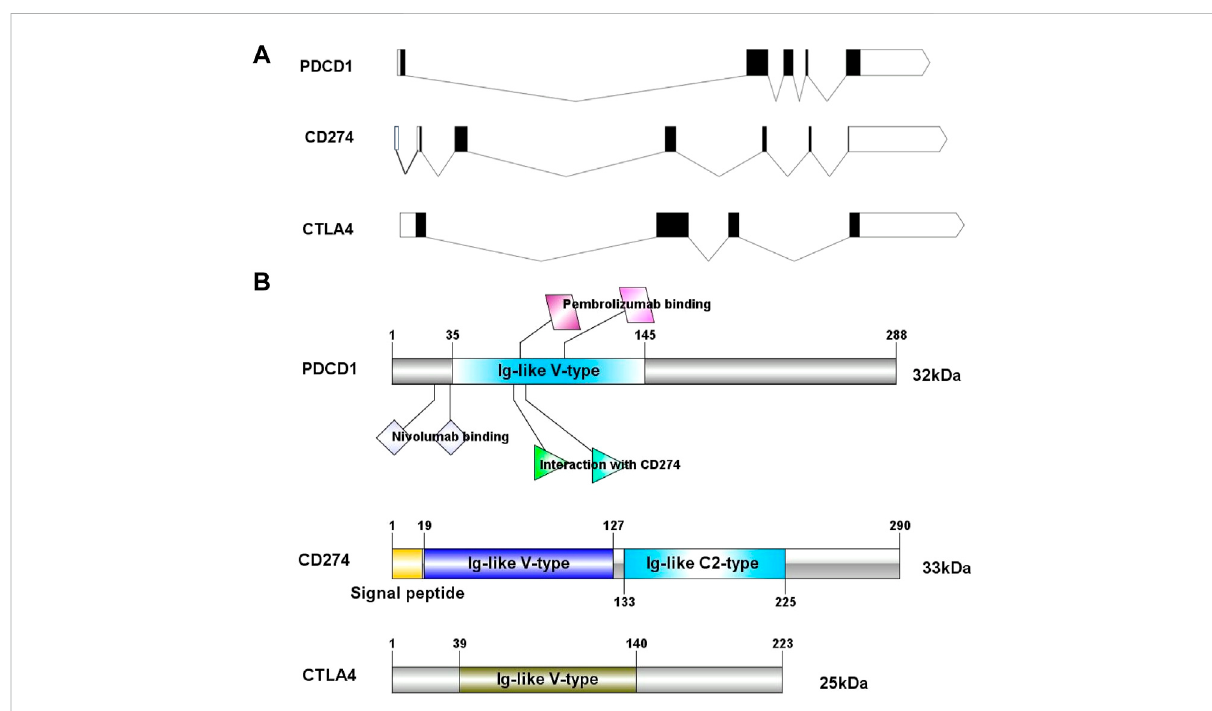
FIGURE 1 The exon-intron structure of PD-1/PD-L1/CTLA-4 genes (A) with domain structure of the corresponding protein (B) . (A) Exons are designated by black rectangles, 5 ′ UTR and 3 ′ UTR -by white rectangles, introns-by horizontal lines. (B) Length for PD-1/PD-L1/CTLA-4 protein (aa) and colored blocks represent protein domains. PD-L1 contains Ig-like V-type domain and Ig-like C2- type domain, PD-1 and CTLA-4 only contain Ig-like V-type